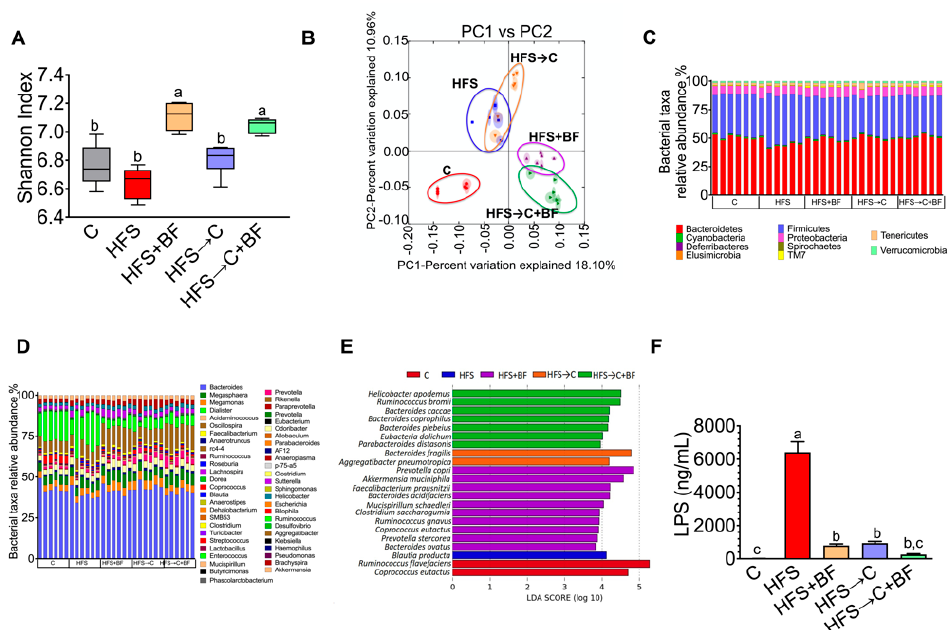
Figure 3. Consumption of bioactive foods decreased metabolic endotoxemia and increased gut microbiota diversity. ( A ) Alpha diversity by Shannon index, ( B ) Principal component analysis of gut microbiota, Relative abundance at ( C ) Phylum level and ( D ) Genus level, ( E ) Lineal discriminatory analysis at species level and ( F ) Serum lipopolysaccharide concentrations in rats fed control (C), high fat diet + 5% sucrose (HFS) with or without bioactive foods (BF). Data are expressed as the mean ± SD. Mean values with different letters show statistical differences between each other. Results were considered statistically significant at p < 0.05.